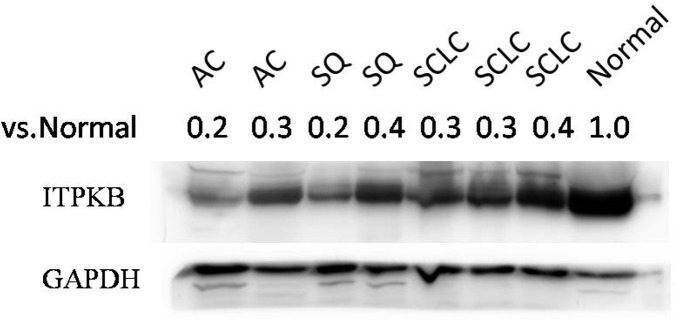
Expression of ITPKB protein in 3 lung carcinoma subtypes.Western blot was used to detect the expression of ITPKB protein in lung carcinoma tissues (2AC samples, 2SQ samples, 3SCLC samples) and adjacent normal lung tissue. The ITPKB protein intensities were normalized by GAPDH.The fold changes were 0.2and0.3 in the comparisons of 2AC vs. normal, 0.2 and 0.4of 2SQ vs. normal, 0.3, 0.3 and 0.4of 3SCLC vs. normal, respectively.